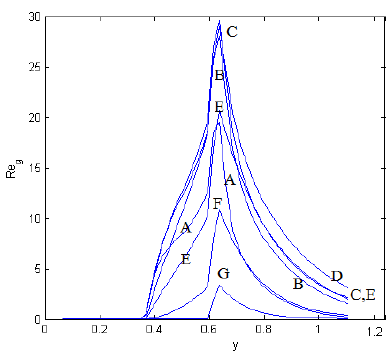
Figure 7. Gas Reynolds number.